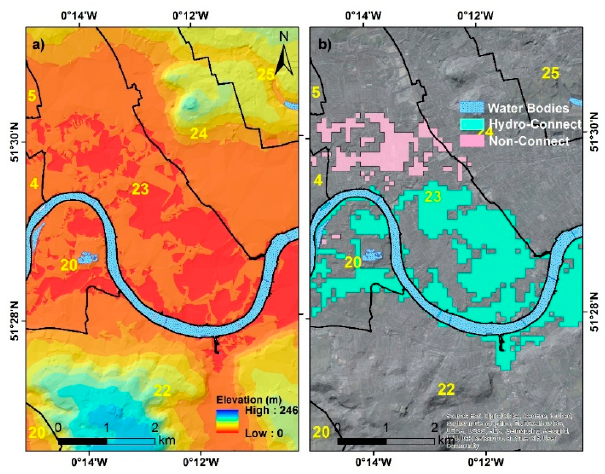
Figure 8. Example showing hydrologically-connected and non-connected pixels in Greater London for a sea-level rise (SLR) of 0.82 m. ( a ) Topography depicted from 5 m OS DEM; ( b ) cells under SLR flood risk and connected to the Thames estuary (cyan) and non-connected cells (violet). Higher elevation areas (e.g., part of borough 24) are not flooded from a SLR of 0.82 m. Varying flood inundation polygons are obtained for GL for the same SLR scenarios with different DEMs (Section 3). For instance, under the UKCP09 scenario, the area of GL estimated to be flooded varies from 61 km 2 (1 m DEM and resampled 30 m DEM), to 64 km 2 (resampled 5 m DEM, and 50 m DEM), to 82 km 2 (5 m DEM from Ordnance Survey), to 49 km 2 (SRTM DEM) (Table A1).